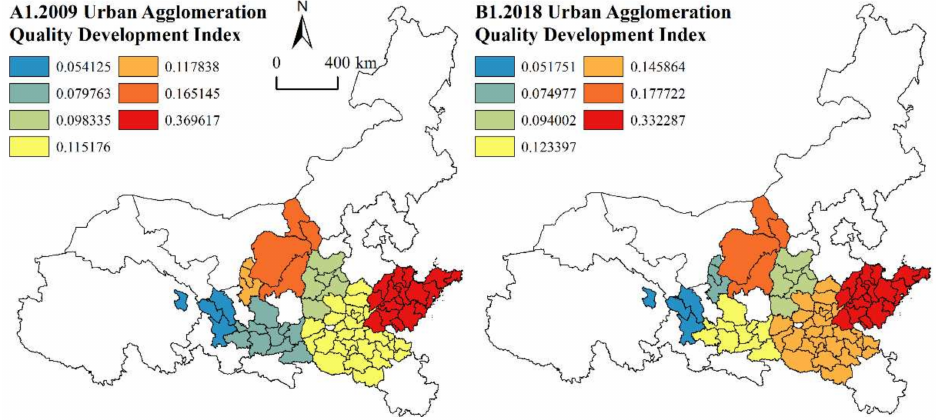
Figure 3. Spatial change in the HQD level of urban agglomerations in 2009 and